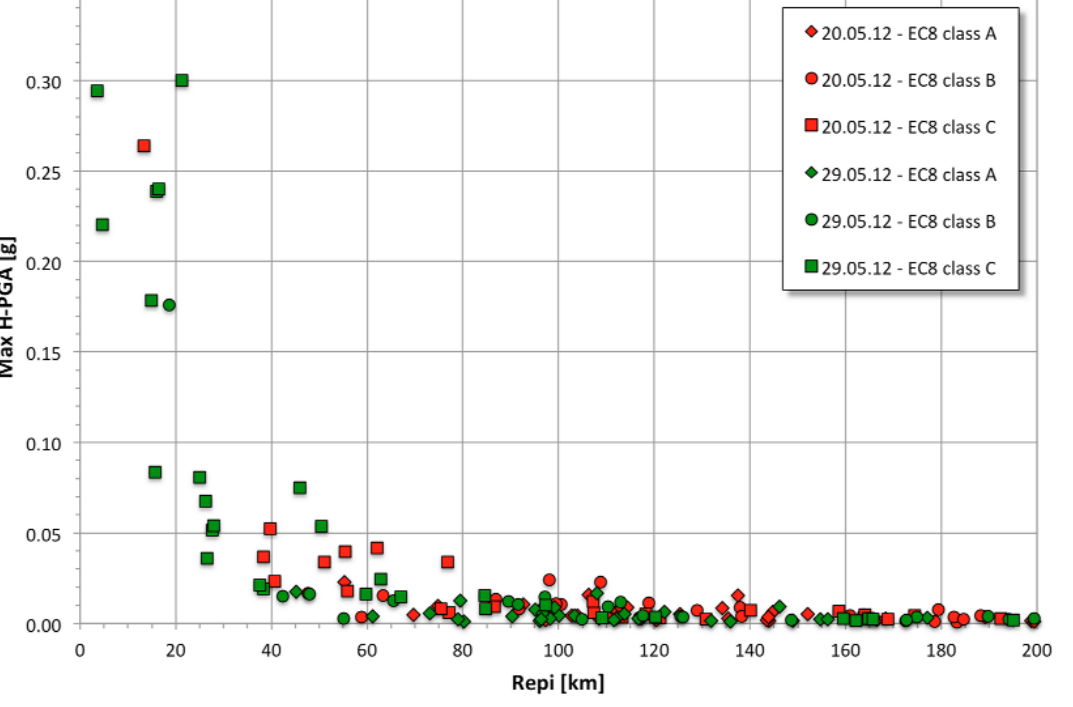
Figure 5. Larger horizontal PGAs (in g) versus the epicentral distance recorded for the May 20 and 29, 2012, earthquakes. The EC8 [CEN 2004] soil class of each station (as assigned based on the geological map) is also